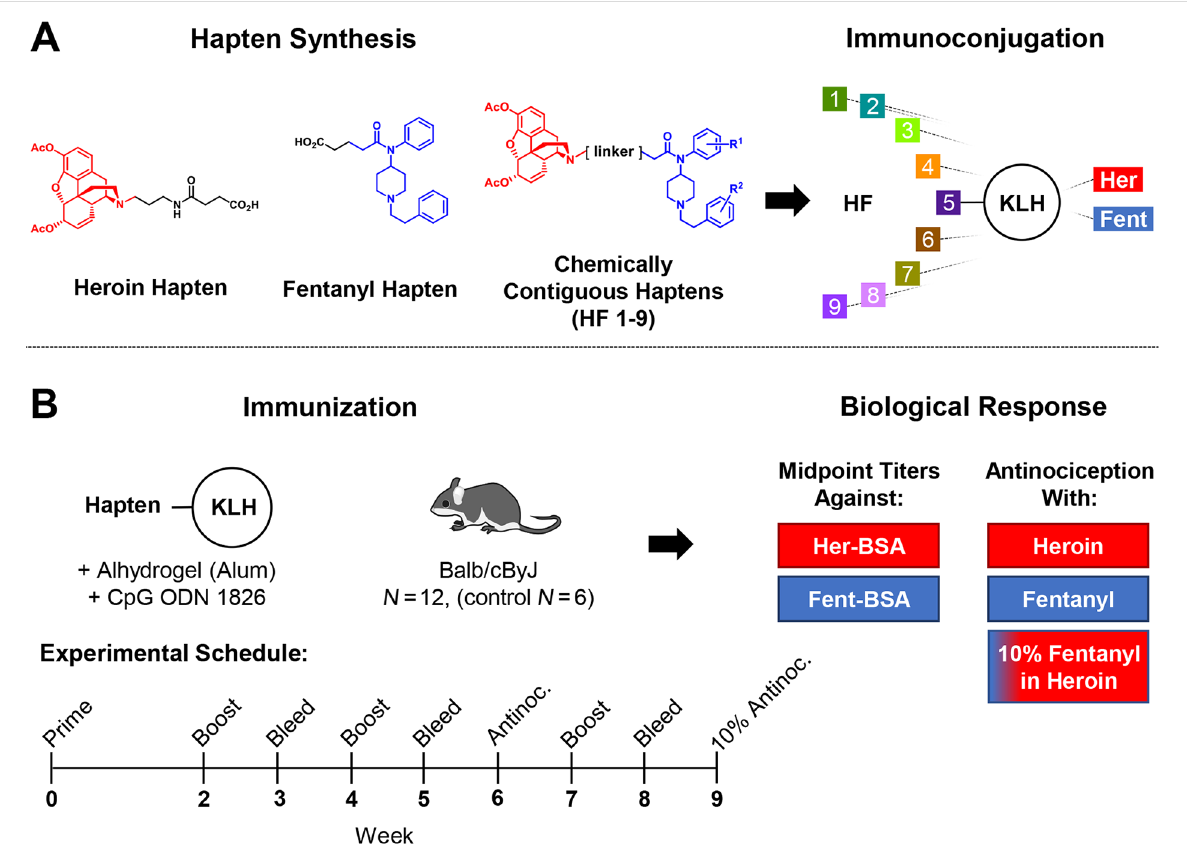
Figure 1: Graphical summary of chemically contiguous opioid vaccine approach. A) Illustration of chemically contiguous heroin-fentanyl concept and immunoconjugation strategy. B) Description of vaccine immunization schedule and metrics used to evaluate each vaccine’s efficacy.